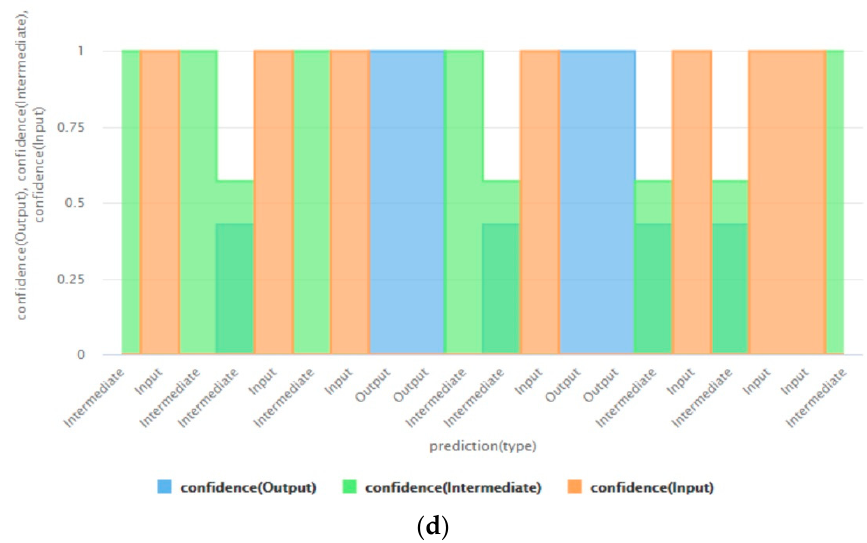
Figure 6. Confidence of predicted stage type: ( a ) input stage; ( b ) intermediate stage; ( c ) output stage; ( d ) comparison of confidence for different stage types.